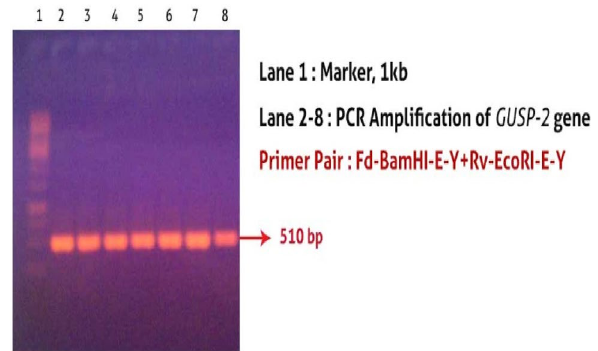
Figure 2. PCR amplification of GUSP-2 gene.